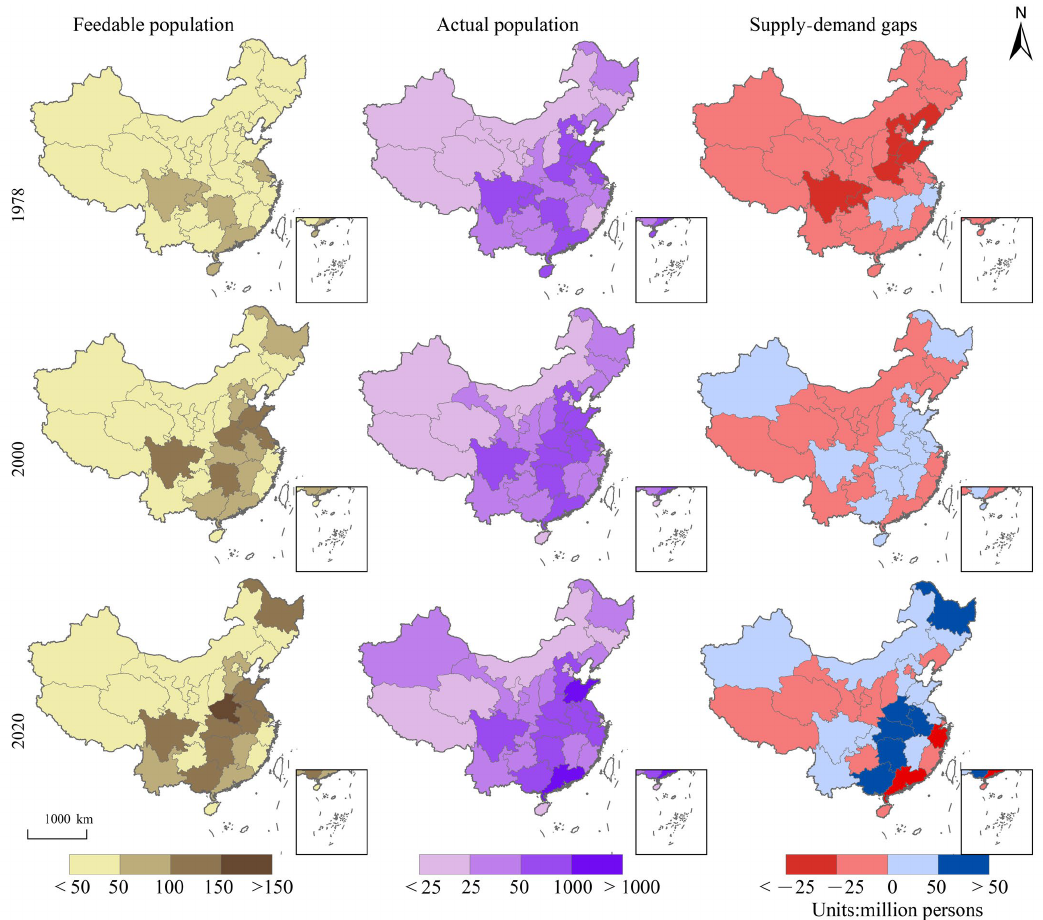
Figure 7. Spatial distribution of food calorie supply–demand equilibrium in China, 1978, 2000, and 2020. During the period 1978 to 2020, the center of gravity for the actual population moved 63.75 km to the southwest (Figure 8a), while the center of gravity for calorie supply moved 204.67 km to the northeast, shifting from Hubei to Henan province in 2020 (Figure 8b). Such spatially reversed movements of “supply” and “demand” (Figure 8c) will exacerbate the pressure on soil and water resources in the north and further increase the need for efficient logistics and trade networks to guarantee sufficient food supply.